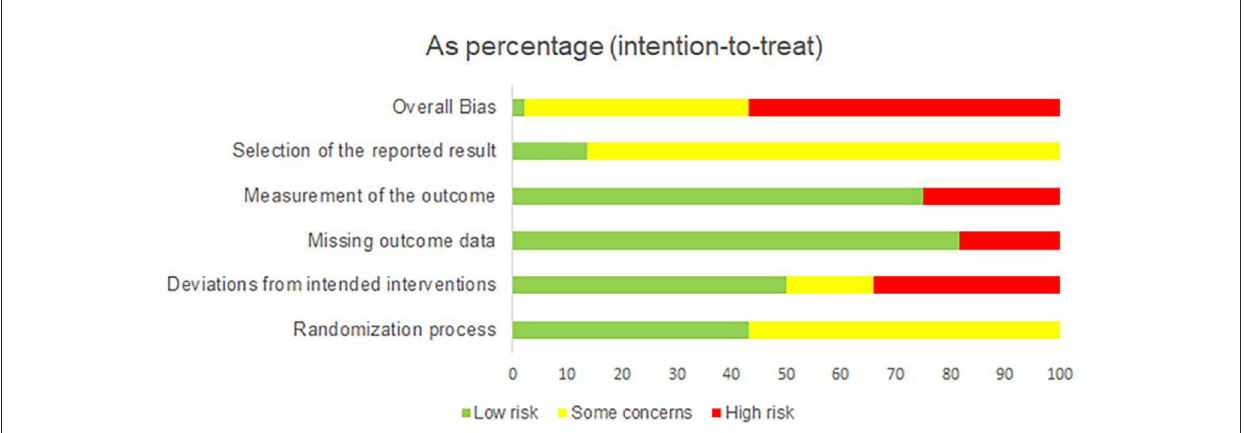
(Figure 5). The funnel plot, Begg’s test (MAL-AOU: P =